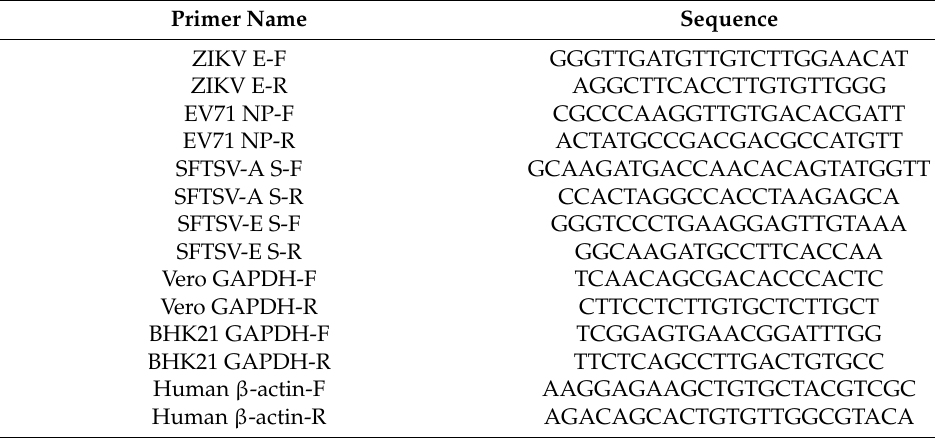
Table 1. Primers used in this